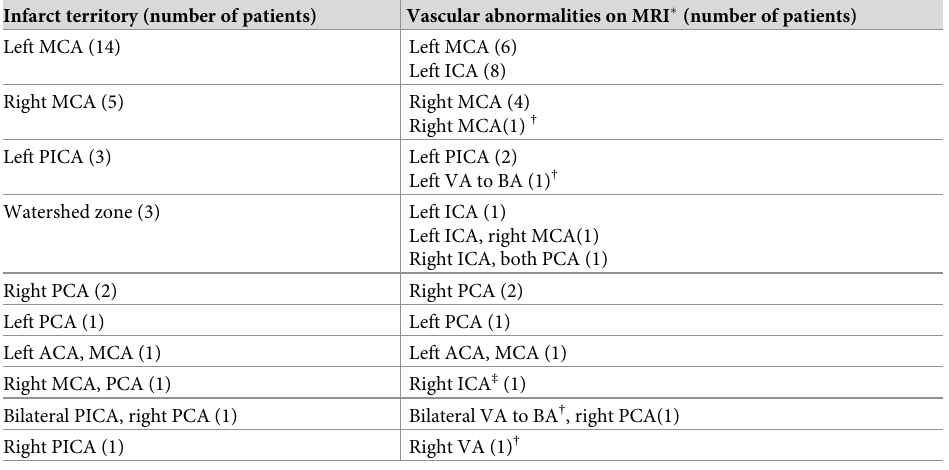
Table 1. Radiologic evaluation of infarcts in 32 patients.